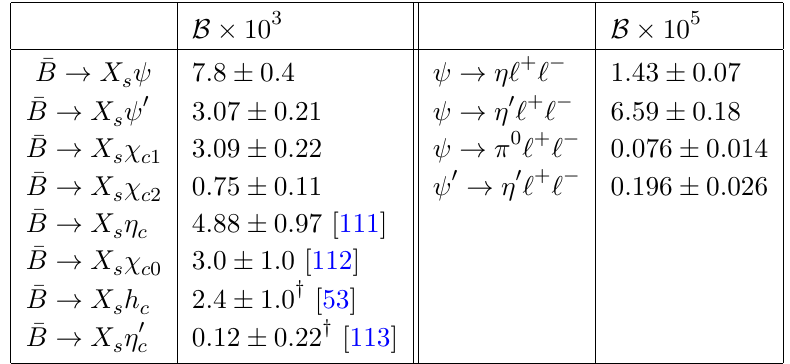
Table 4 . Branching ratios of (direct) inclusive B -decay into charmonium, and of vector charmonium dilepton decay to light pseudoscalars. Numbers marked with otherwise stated are taken from the PDG